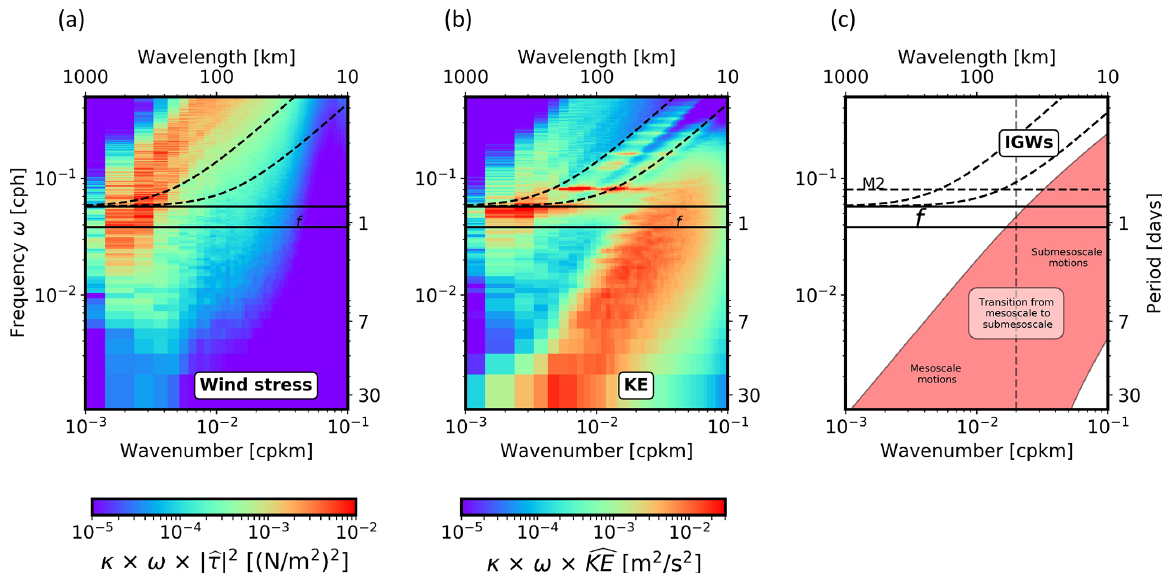
Figure 2. COAS frequency-wavenumber spectra of (a) surface wind stress and (b) surface currents in the Kuroshio Extension region in winter. Panel (c) is a Stommel diagram of oceanic motions (see text). The dashed lines in the three panels show the linear dispersion relation curves for internal gravity waves (IGW) associated with the first four baroclinic modes, which helps to identify energetic internal gravity waves. See Torres et al. (2018) and Qiu et al. (2018) for a detailed explanation of the above